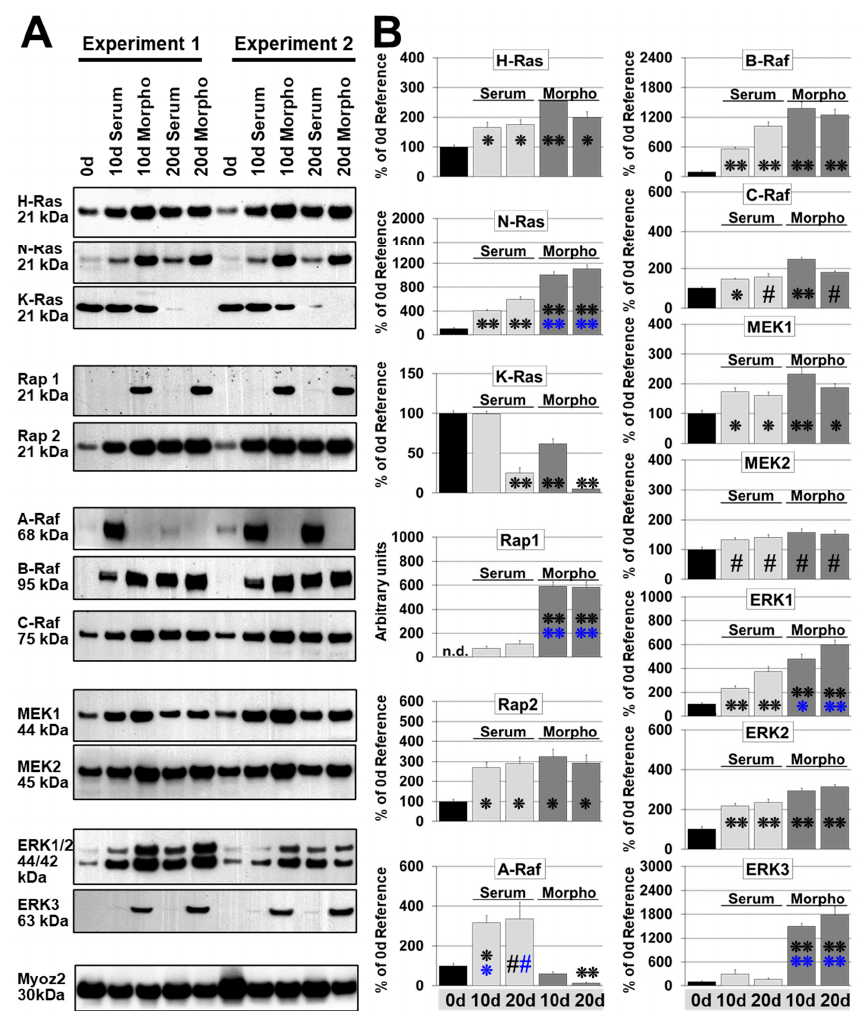
Figure 5. MAPK remodeling in dedifferentiating cardiomyocytes is distinct from hypertrophic myocytes. Primary cultures of adult cardiomyocytes were harvested at the experimental start (0 d, reference), and after 10 (10 d), and 20 days (20 d) for western blot analysis. Cultures were stimulated with 5% serum (Serum) and conditioned supernatant (Morpho, 80%) of cardiac microvascular endothelial cells containing no growth supplements. Single and double stars indicate p < 0.01 and p < 0.001, respectively. Black stars refer statistically to Con, blue stars to serum. Hash signs indicate p < 0.05. For A-Raf blue symbols refer statistically to morphogens. ( A ) Total protein (10 µg) was analyzed for the expression of components of the Ras/Raf/MEK/ERK pathway, as well as the Ras-related proteins Rap1 and Rap2. MYOZ is Calsarcin-1 and serves as a loading control. Note that we detected Erk3 as the 63 kDa form but not as full length 90 kDa protein. Detected molecular sizes are indicated. ( B ) Quantitative evaluation and statistical analysis of ( A ). Note that the order of groups is presented differently from ( A ).